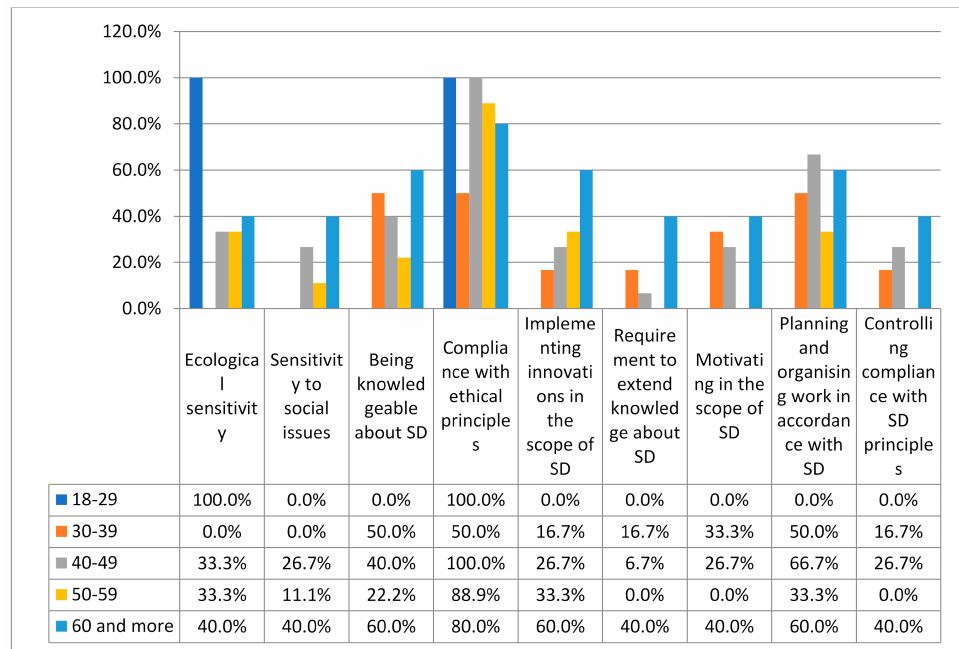
Figure 4. Energy companies’ managers in breakdown into age categories. Views about partic- ular traits and actions of a sustainable manager compliant with the model profile (scores of 5). SD—sustainable development. Source: own